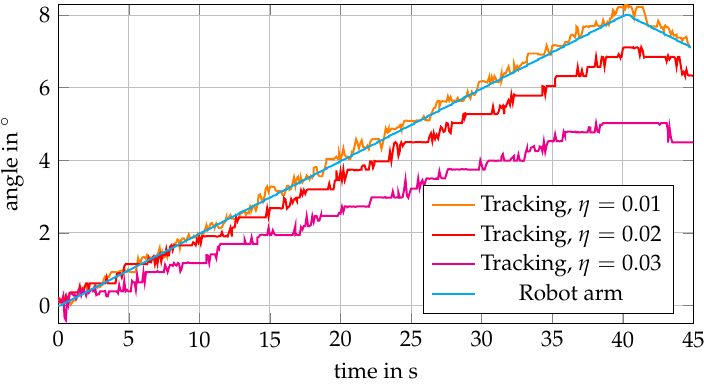
Figure 10. Exemplary curves of estimated angles and robot arm angles for in-plane rotations at 0.2 ◦ /s and a maximum angle of 8 ◦ (compare Figure 9a). When increasing the learning rate η , the angle is increasingly